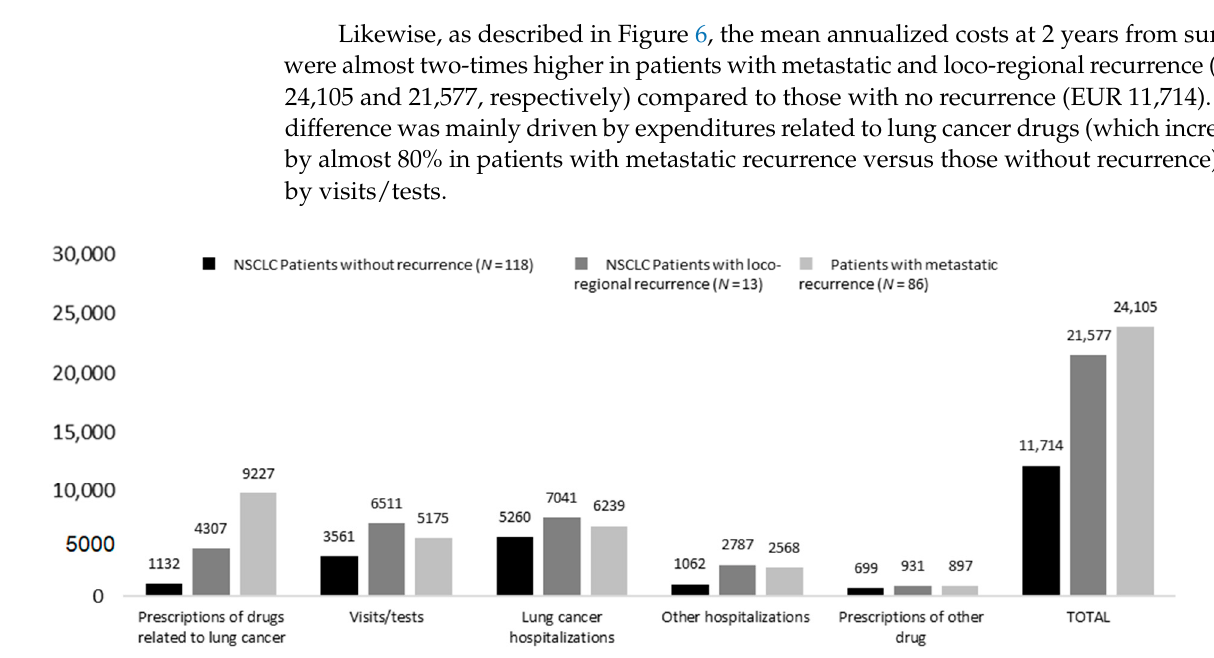
Figure 6. Annualized healthcare direct costs during first 2 years after surgery among alive patients— inclusion period January 2015–June 2019, stratified by recurrence status.